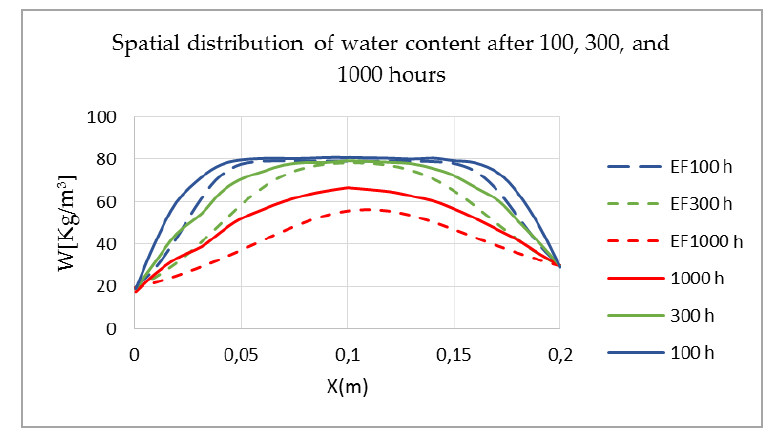
Figure 5. Spatial distribution of water content after 100, 300, and 1000 h [25].